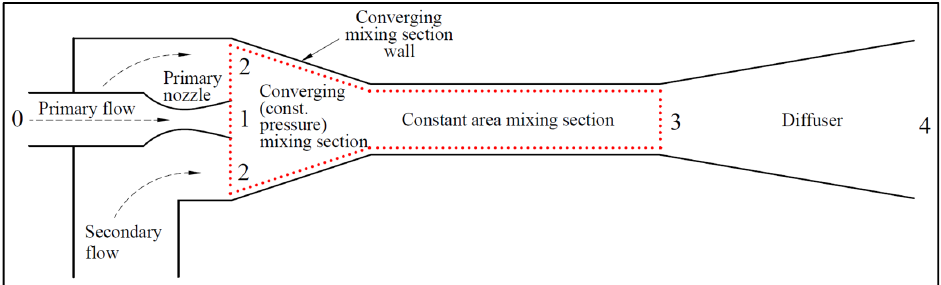
Figure 11. The dotted line is showing control volume C.